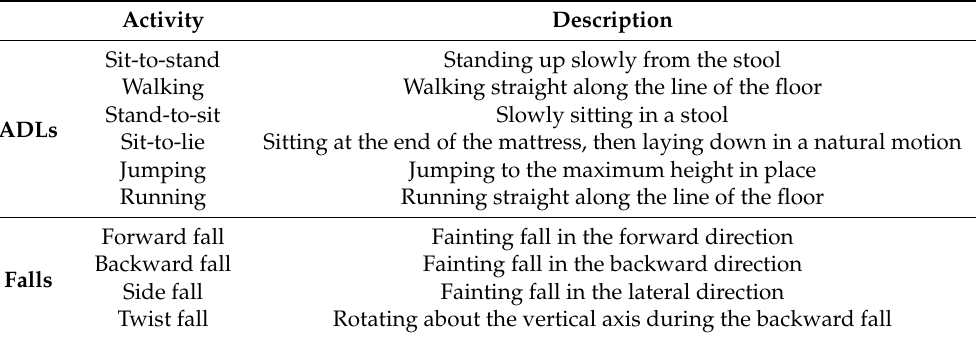
Table 1. Description of activities. ADL = activities of daily